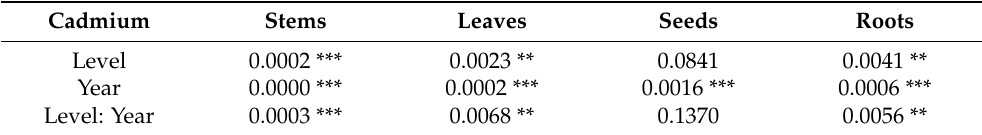
Table 7. Two-way ANOVA of the main factor and interaction for the concentration of cadmium in stems, leaves, seeds, and roots during the two years of the experiment (** significance level at p ≤ 0.005, *** significance level at p ≤ 0.001).